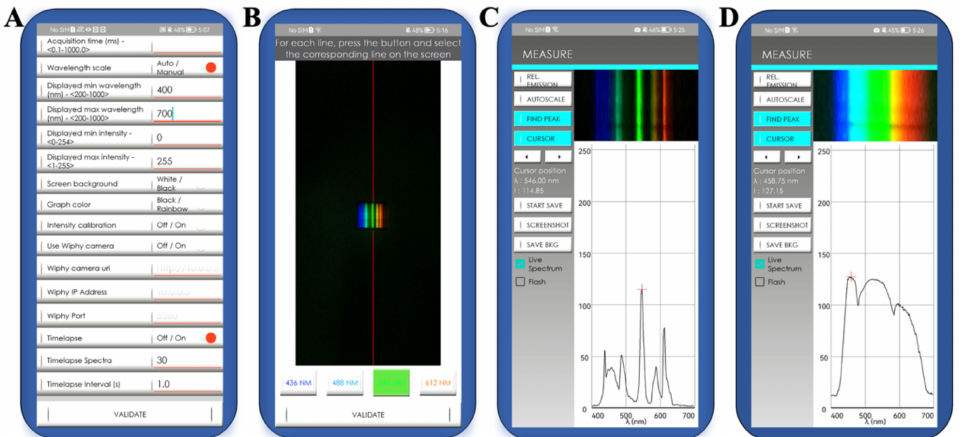
Figure 2. Operating interface of GoSpectro app (Android) on the smartphone. ( A ) Detection parame- ter settings; ( B ) calibration operation with calibration light source; ( C ) detection of mercury lamp; and ( D ) detection of white light source.